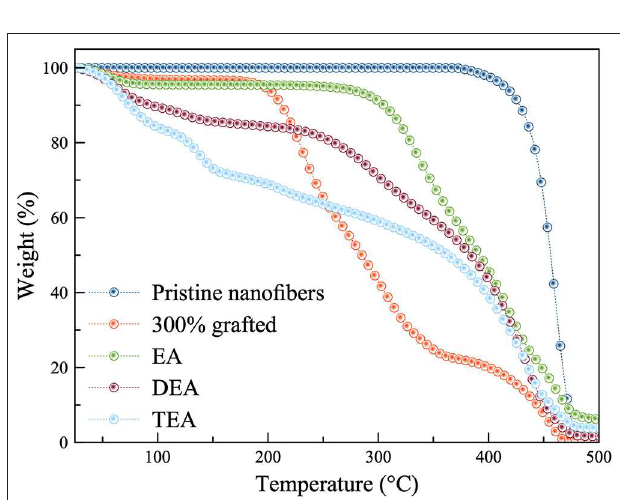
FIGURE 7 | TGA of pristine, poly(GMA) grafted, EA, DEA, and TEA aminated s-PP